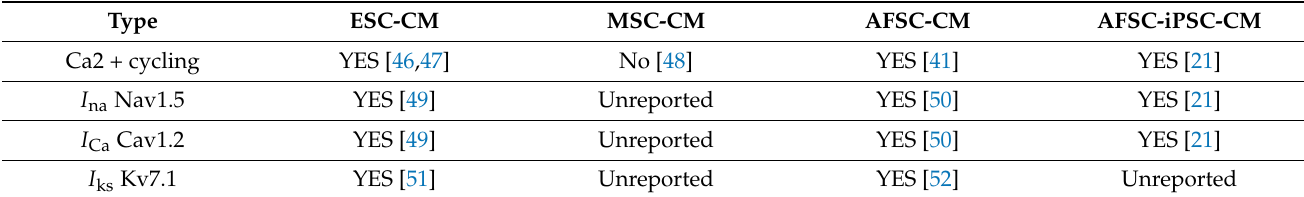
Table 3. Comparison of ion currents of in vitro derived